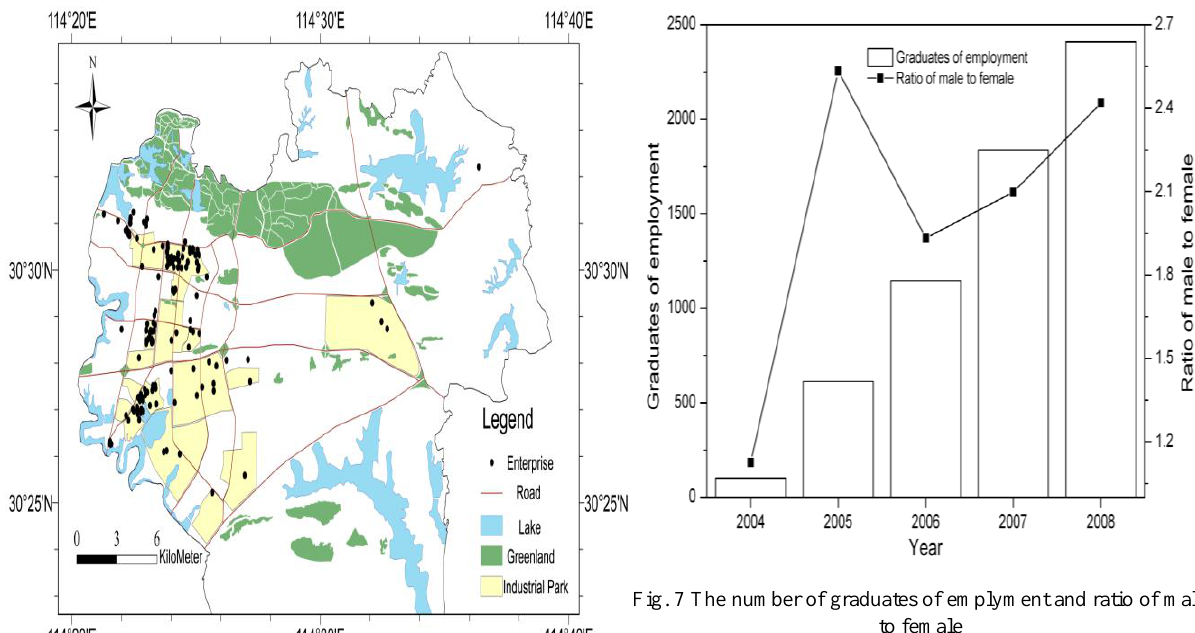
Fig. 7 The number of graduates of emplyment and ratio of male to